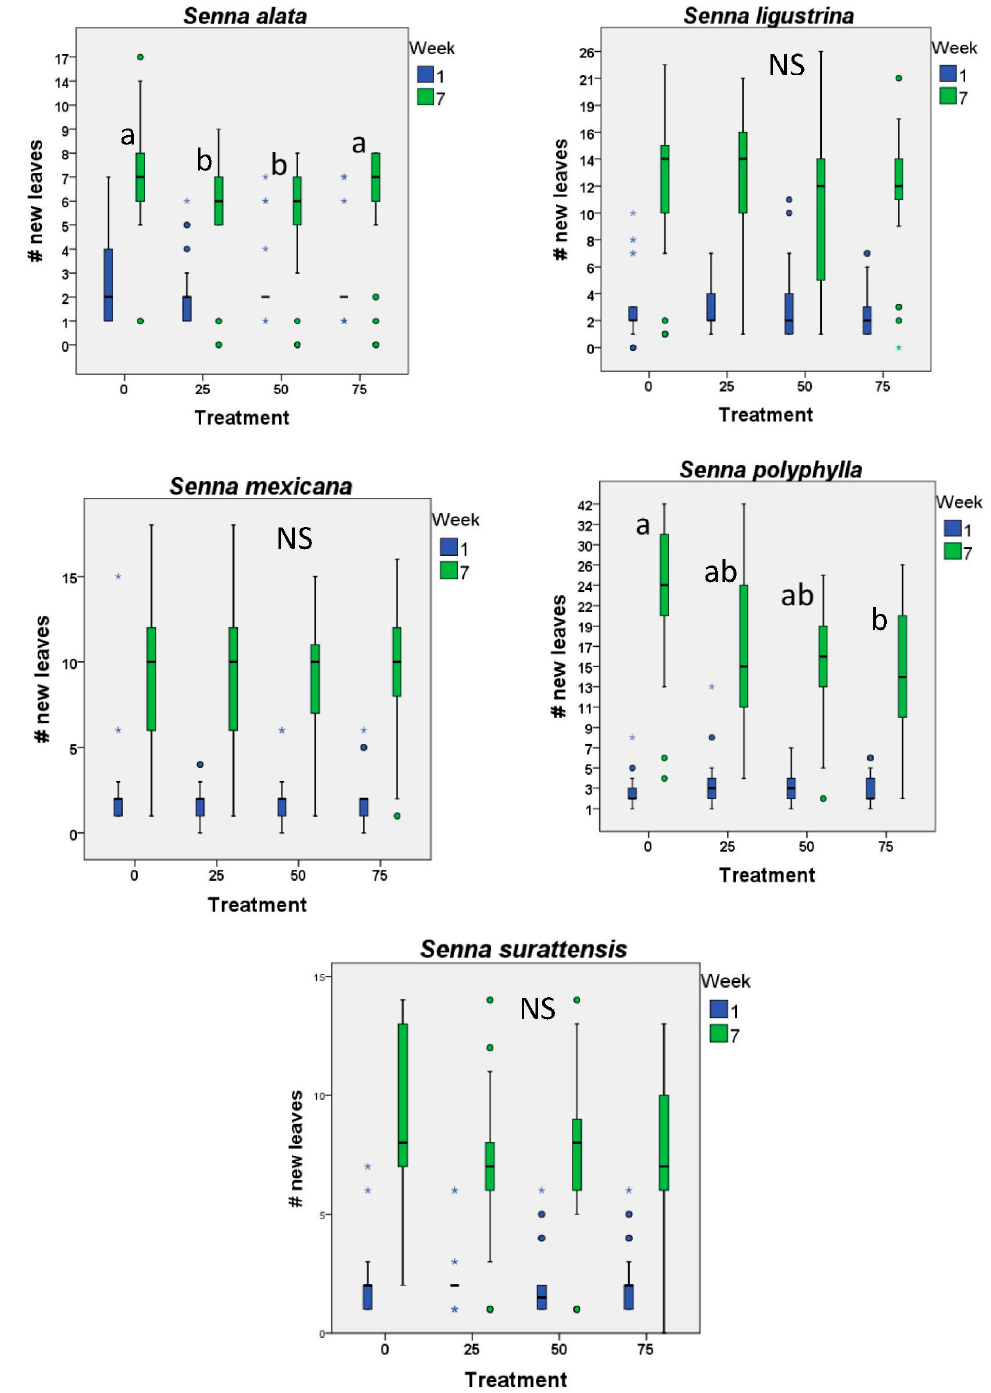
Figure 2 . New leaves—bar and whisker plots for initial number of leaves and final number of new leaves produced on five species of Senna subject to different levels of artificial defoliation over the first two months of life (n = 22 plants each level and control). In no case were the initial number of leaves different among the treatment groups. Small letters by bars indicate significant differences ( p < 0.05); bars with the same letters do not differ significantly from each other. NS indicates no significant differences found.